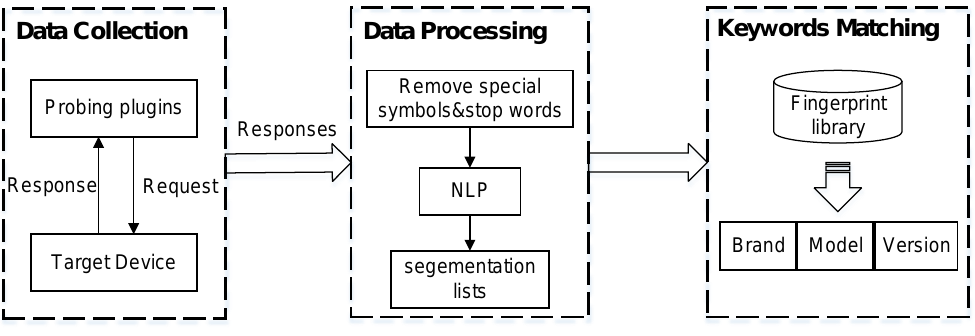
Figure 4. The process of data